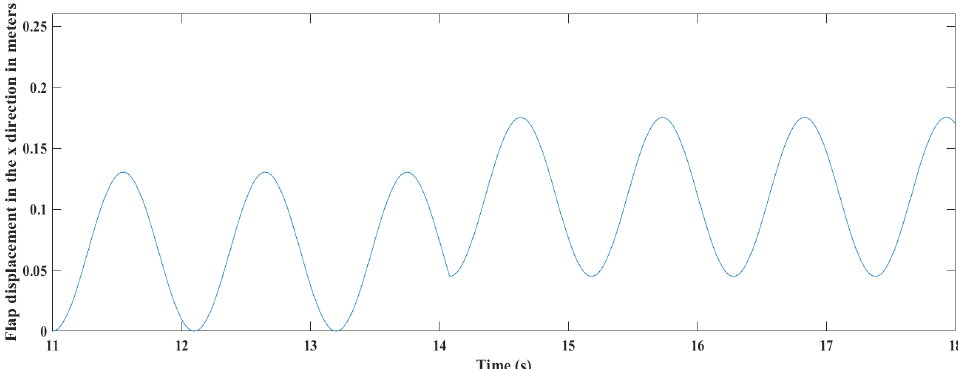
Figure 9. Flap displacement in the x direction in meters.